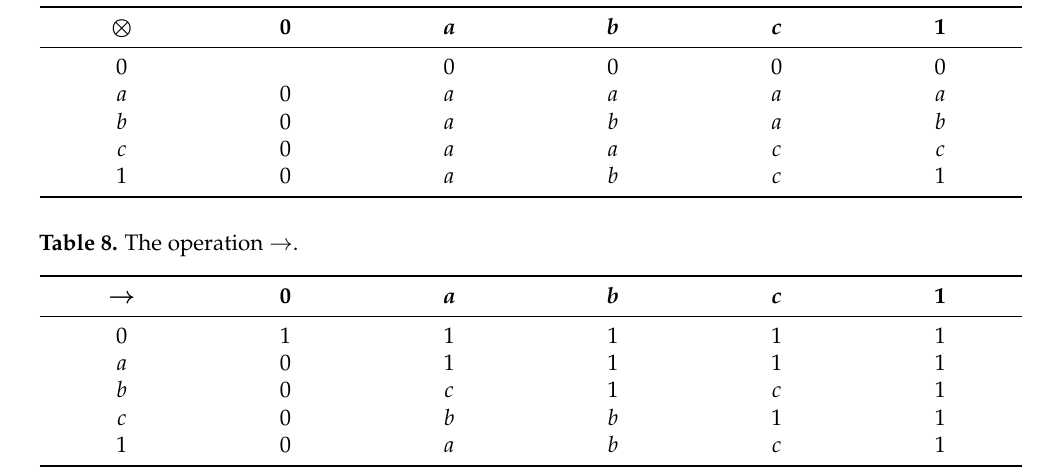
Figure 3. Hasse diagram of lattice L . Table 7. The operation ⊗ .